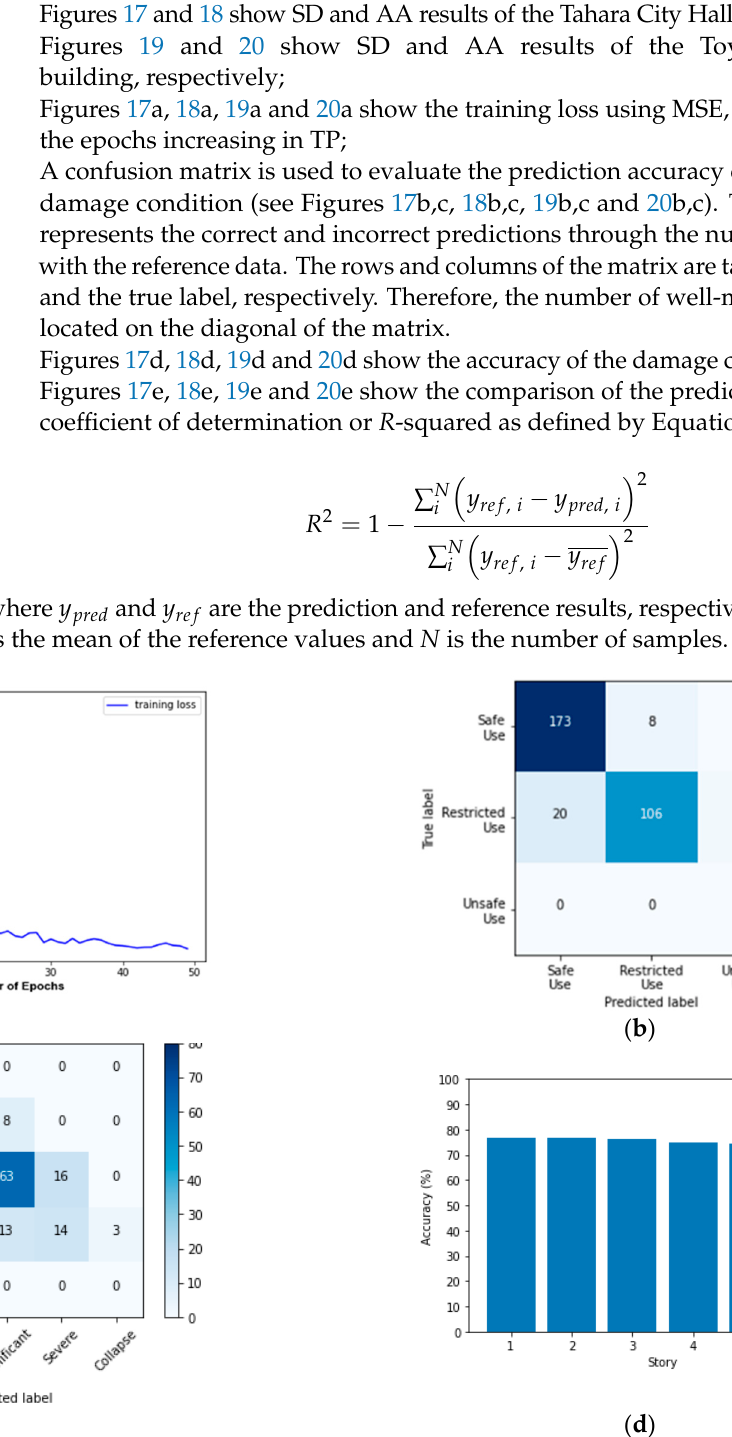
( e ) Figure 17. SD results of the TP and VP for Tahara City Hall building: ( a ) Convergence curve—loss in the TP; ( b ) confusion matrix—usability of the building by VP; ( c ) confusion matrix—total dam- age condition by VP; ( d ) confusion matrix—storey damage condition by VP; ( e ) total comparison of SD. ( a )